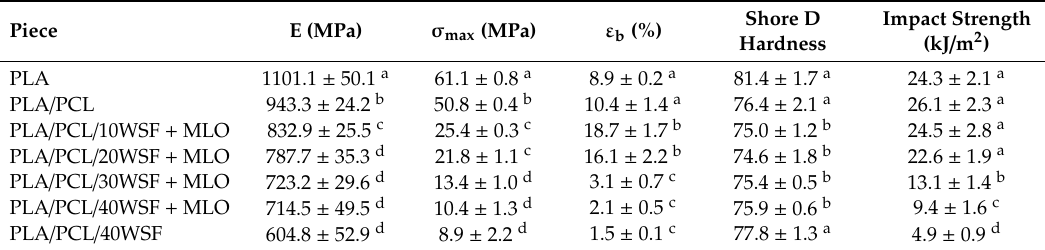
Figure 2. Field emission scanning electron microscopy (FESEM) micrographs of walnut shell flour (WSF) taken at ( a ) 250 × and ( b ) 1500 × showing scale markers of 60 µ m and 10 µ m, respectively; ( c ) Particle size histogram of WSF. Table 2. Summary of the mechanical properties of the green composites made of polylactide (PLA), poly( ε -caprolactone) (PCL), walnut shell flour (WSF), and maleinized linseed oil (MLO) in terms of: tensile modulus (E), maximum tensile strength ( σ max ), elongation at break ( ε b ), Shore D hardness, and impact